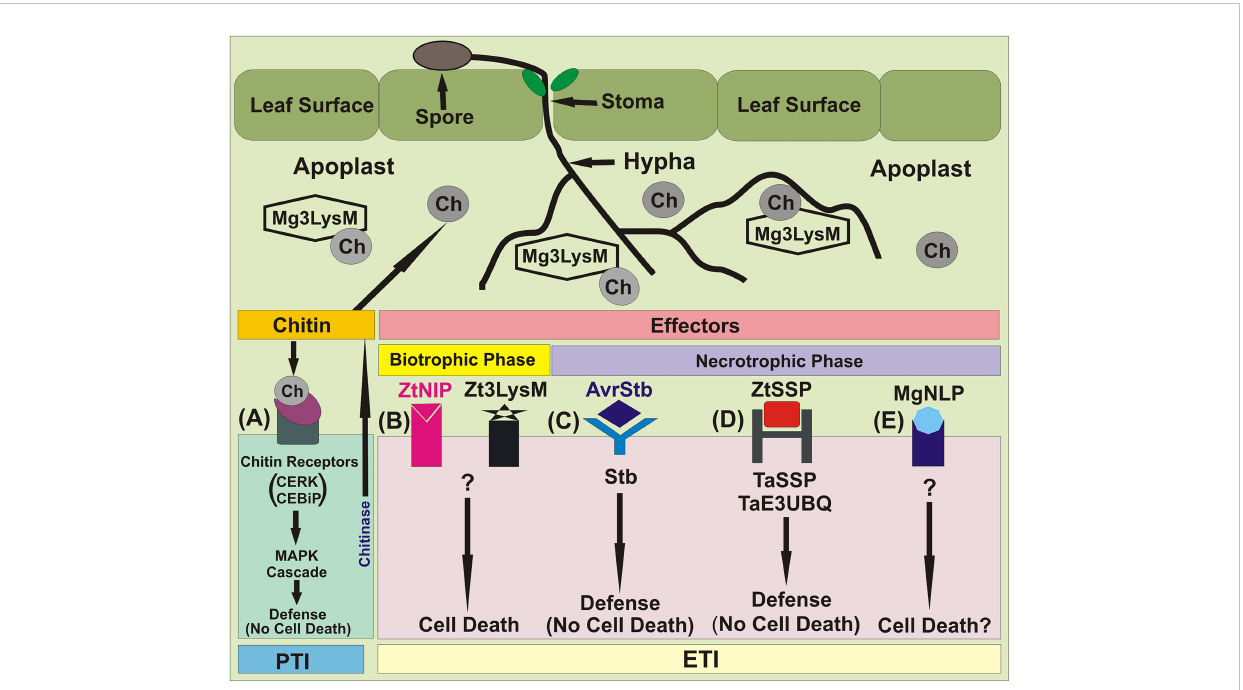
FIGURE 3 Major molecular events during Z. tritici – wheat interactions. (A) Fungal PAMP chitin is recognized by the host receptors Chitin Elicitor Binding Protein (CEBiP) and Chitin Elicitor Receptor Kinase 1 (CERK1), triggering MAP kinase cascades and immune activation. Multi-functional LysM-domain containing effector Mg3LysM scavenges chitin to suppress immunity and protects fungal hyphae from wheat chitinases. (B) ’ Necrotrophic ’ effectors (NEs), Necrosis-Inducing Protein 1/2 (ZtNIP1/2) and and LysM effector (Zt3LysM) induce host cell death. (C) Stb gene-speci fi ed resistance, presumably triggered following recognition of cognate fungal effectors (AvrStb) secreted into the apoplast. This results in arrest of pathogen growth via an unknown mechanism that does not involve HR. (D) The NEP1-like effector protein MgNLP (unknown Z. triticini effector, predicted by bioinformatics analysis) has an unknown function(s) during wheat infection, but triggers cell death in dicots. (E) Small secreted proteins (ZtSSPs) of Z. tritici , which act as an effector. The TaE3UBQ synthesize in the wheat and interacts with the ZtSSPs resulting inhibition of the growth of Z. tritici